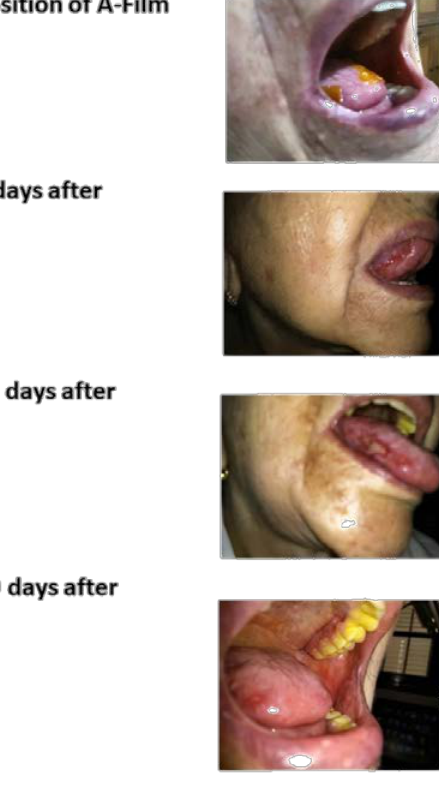
Figure 13. The picture at the top shows the position of the films covering the wounds of the tongue. A film was placed on each cheek and another was placed on the palate. In the sequence, the photos show the mucositis regression course. The cheeks and palate were not photographed because the patient was unable to open her mouth wide enough. On the 30th day of treatment, it is possible to notice the evolution toward healing and a few red spots on the cheeks. The yellow pigmentation on the teeth is from the dye, and it was easily removed in oral hygiene.